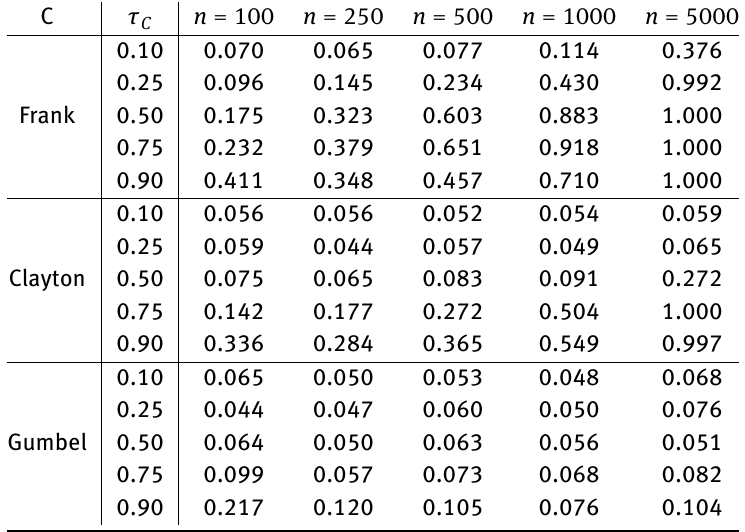
Table 7: d = 3 : Empirical power of the test for ellipticity with significance level α = 0.05 based on the test statistic T n : rate of